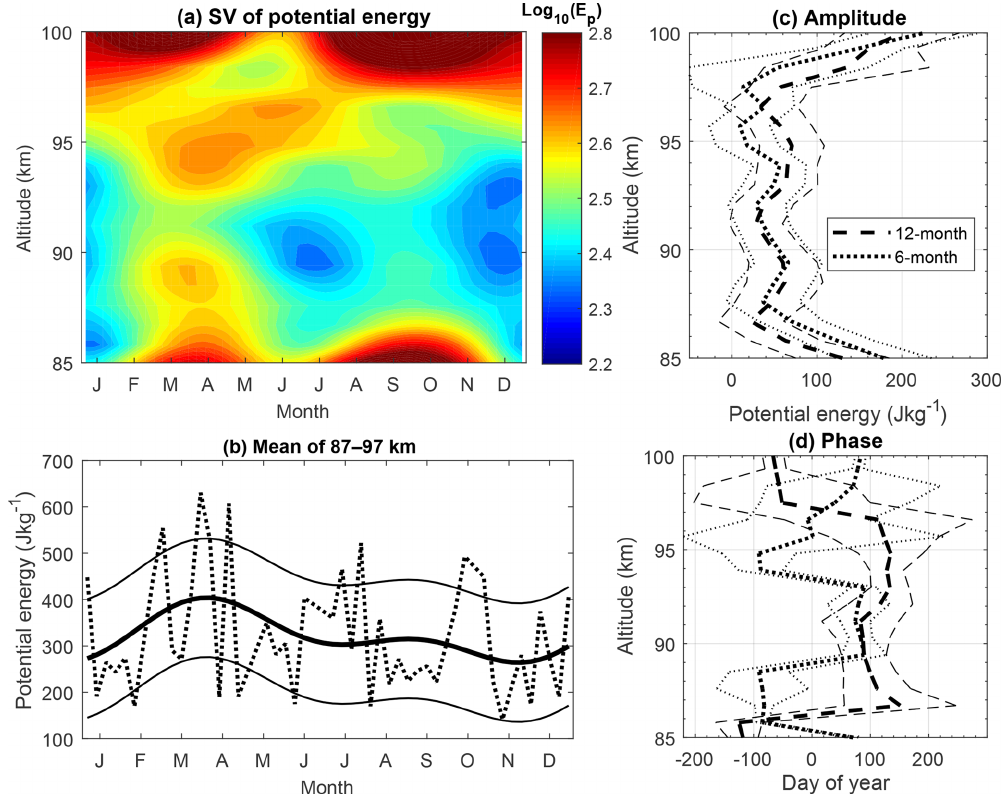
Figure 9. (a) Seasonal variations of the harmonic fitted potential energies plotted versus altitude and month. (b) Observed (dotted curve) and harmonic fitted (thick solid curve) mean potential energy between 87 and 97km, where the width between the thin solid curves and the thick solid curve is 1 σ . (c) 12-month (thick dashed line) and 6-month (thick dotted line) amplitudes and their 1 σ deviations (thin lines). (d) 12-month (thick dashed line) and 6-month (thick dotted line) phases and their 1 σ deviations (thin